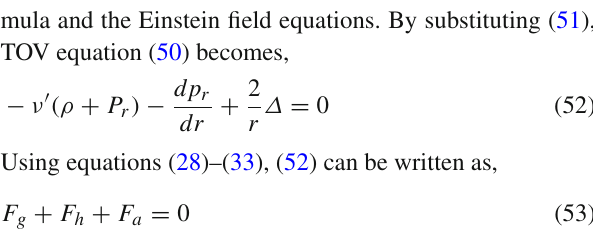
Fig. 14 Energy condition